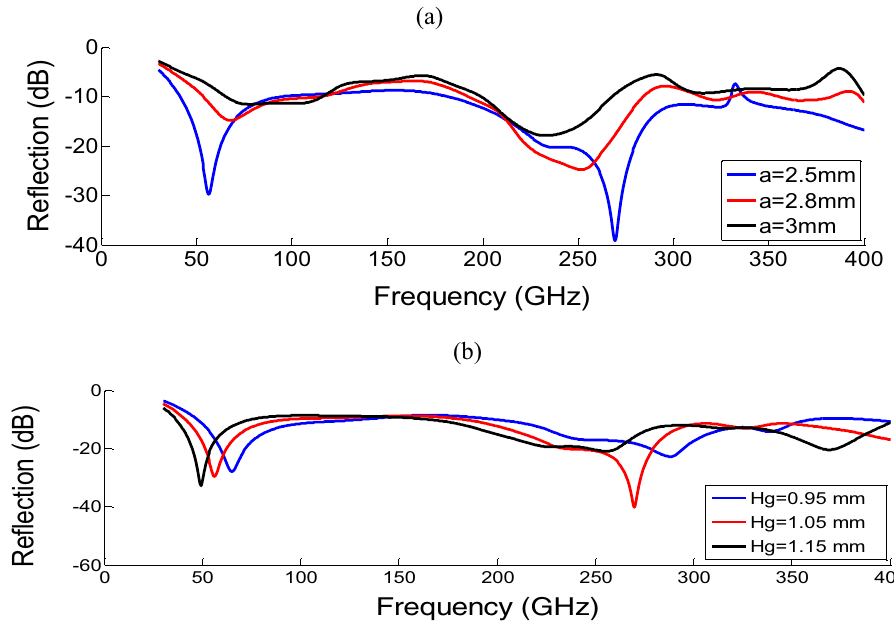
Figure 3. Reflection of the MA with the normal incidence for the physical parameters of ( a ) a (width of the unitcell), Hg = 1.05 and ( b ) Hg (height of the graphite film), a = 2.5.